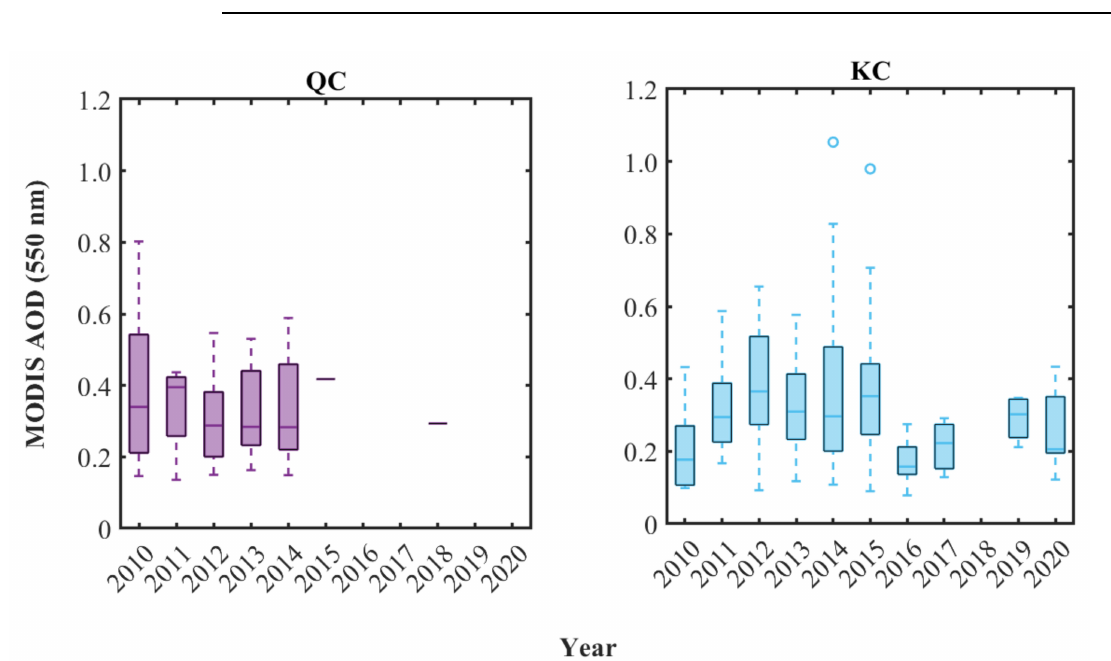
Figure 5. Boxplots of annual concentrations of evaluated MODIS AOD data from 2010 to 2020 in Quezon City and Koronadal City; median is shown by the middle line of the box, inter-quantile range is shown by the box, and whiskers represent the ± 2.7 + inter-quantile